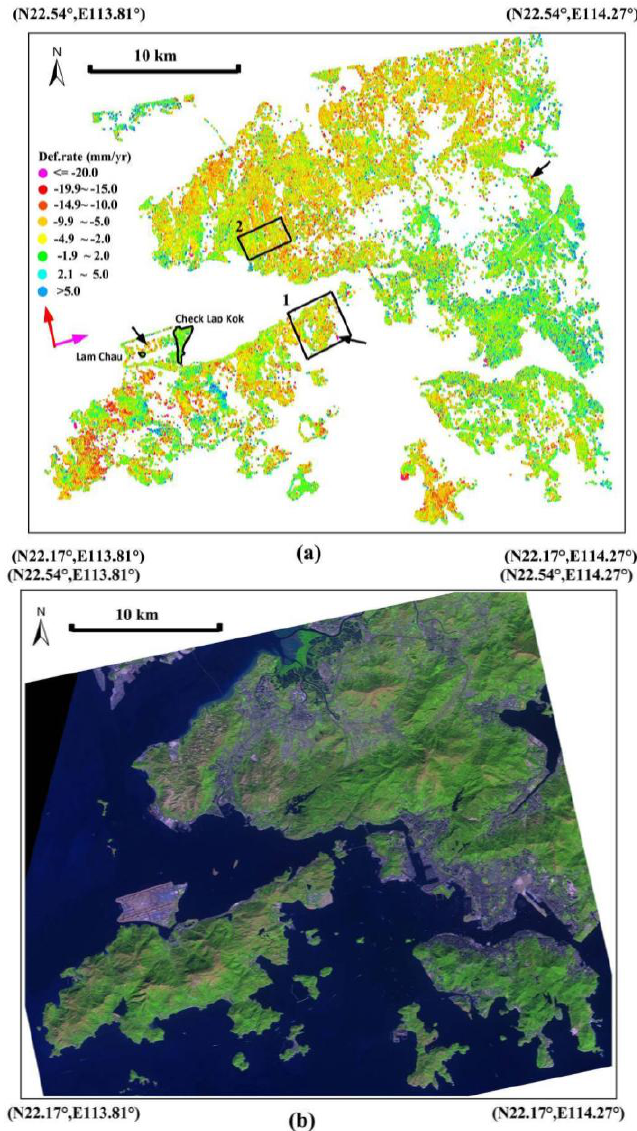
Apart from the reclamation lands (marked by the black arrows in Figure 5a, showing areas of settlements), a portion of the mountainous region, e.g., Lantau Island, western and northwestern parts of New Territories, was unstable with LOS values larger than ±2.0 mm/yr (an appropriate threshold closing to the measurement sensitivity of the SB-InSAR approach, which discriminates moving from nonmoving targets). The SB-InSAR derived signature confirmed that the natural slopes over Hong Kong were unstable jointly as a result of the environmental conditions (e.g., loosely compacted rock- weathered mantle) and external triggers (e.g., over-urbanization and heavy rain falls). Figure 5. ( a ) ALOS PALSAR-derived surface annual motion rates over Hong Kong using the SB-InSAR method; the black arrows indicate reclamation lands; the red and pink arrows indicate the satellite flight path and looking direction of line of sight, respectively; black rectangles ―1-Disneyland, Lantau Island‖ and ―2-Tai Lam, Yuen Long, New Territories‖ indicate the TerraSAR monitoring sub-regions. Black polygons indicate the original Lam Chau and Check Lap Kok Island; ( b ) SPOT 5 imagery indicates the land cover of Hong